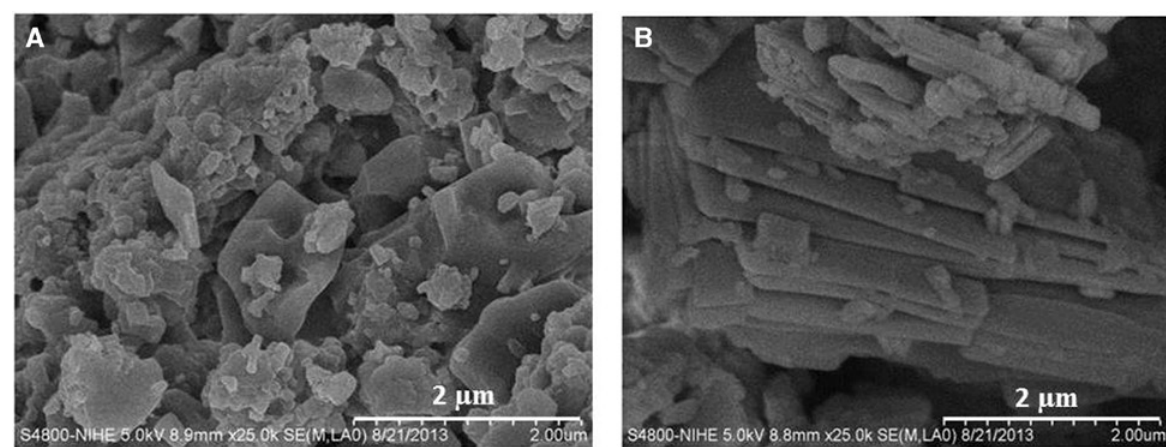
Figure 5: Scanning electron microscopy (SEM) images of Cu-BTC, formed from Cu and benzene-1,3,5-tricarboxylic acid, synthesized with (A) tetrabutylammonium tetrafluoroborate (TBATFB) and (B) NaNO